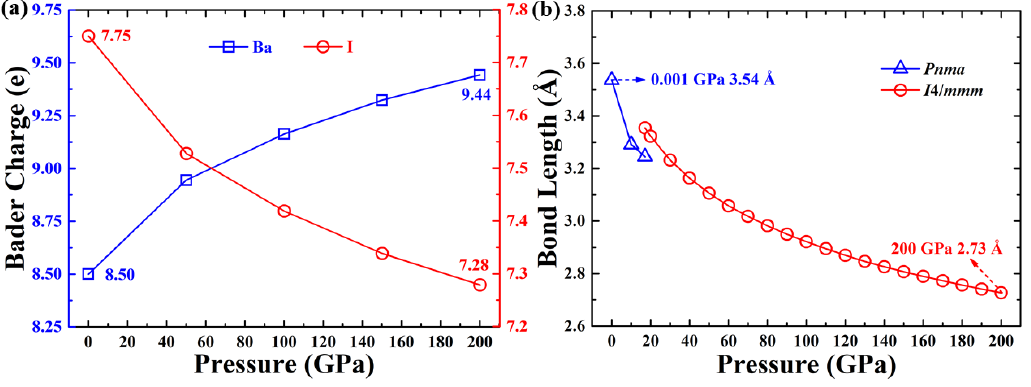
Figure 3. ( a ) Simulated Bader charge for BaI 2 . ( b ) The distance between B and I atoms.